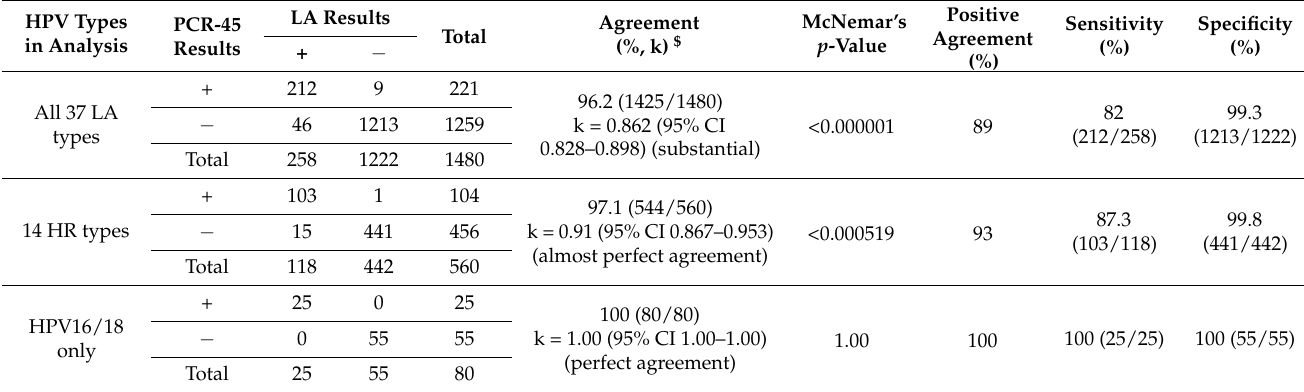
Table 2. HPV type-specific concordance between PCR-45 and